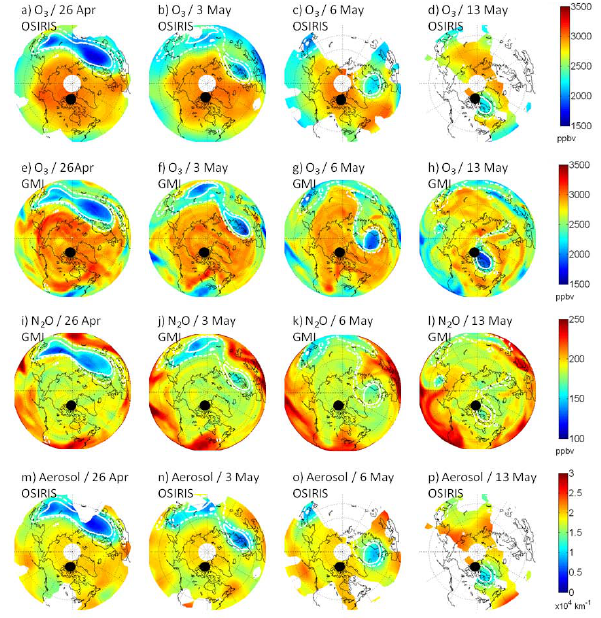
Fig. 9. Polar maps at the 500-K ( ∼ 18km) potential temperature level of OSIRIS ozone VMR in ppbv (top row), GMI ozone VMR in ppbv (top middle row), GMI N 2 O VMR in ppbv (bottom middle row), and OSIRIS aerosol extinction at 750nm in 10 4 km − 1 (bot- tom row) for 26 April and 3, 6, 13 May 2011. Low [high] VMRs and aerosol extinctions are given in blue [red]. The white dashed lines indicate sPV = 1 . 2 × 10 − 4 s − 1 (the approximate outer vortex edge) and the thick white lines indicate sPV = 1 . 6 × 10 − 4 s − 1 (the approximate inner vortex edge). Eureka is indicated by the black circle.